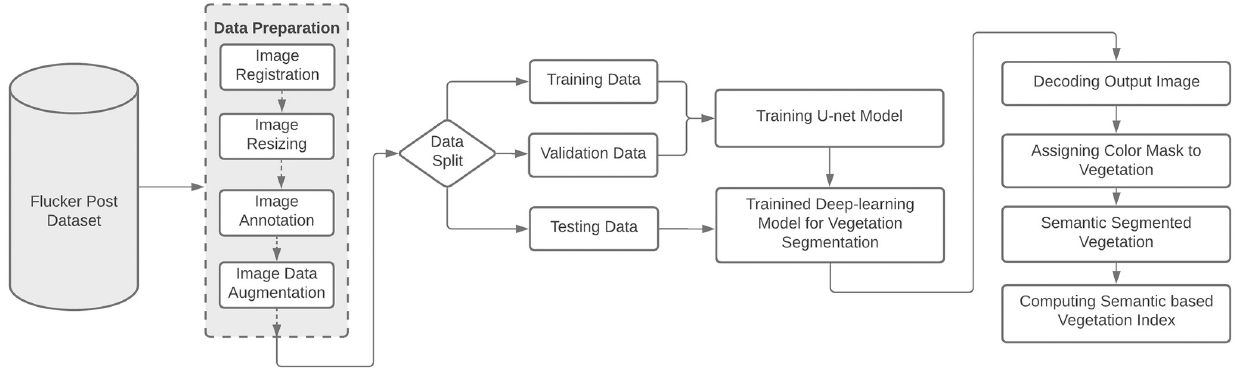
Fig 1. The general data flow diagram shows how the proposed system for checking the health of plants would work.